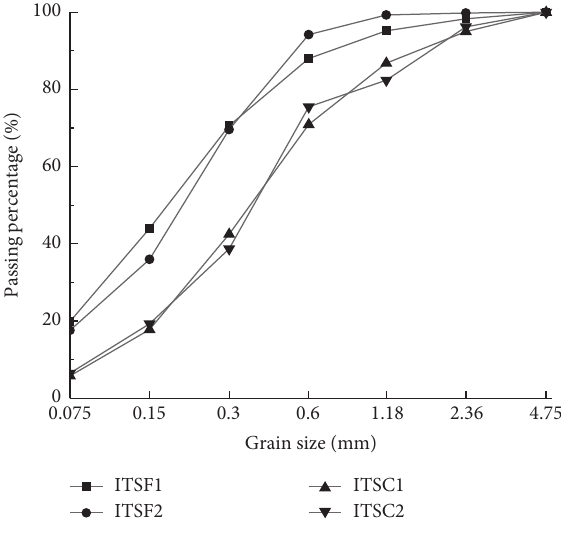
Figure 1: Passing percentage results.